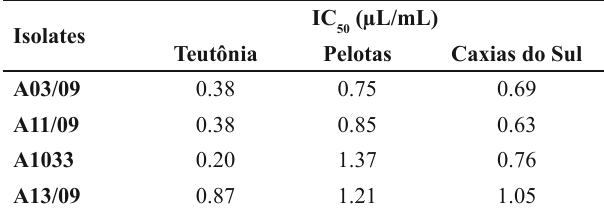
Ef fi ciency of three chemotypes of Lippia alba essential oils on fungicidal activity against Alternaria solani isolates. IC were determined by plotting the concentration of essential oils required to achieve a 50% reduction of mycelial